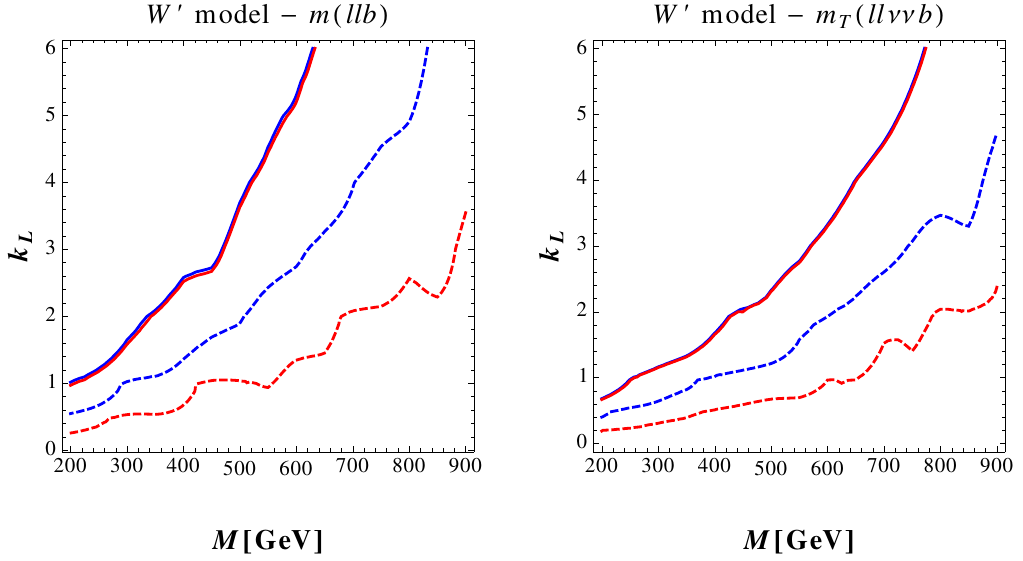
Figure 10 . 95% CL expected exclusion regions in the M vs k L plane: the left plot makes use of the m ( llb ) distribution while the right plot makes use of the m T ( ll(cid:23)(cid:23)b ) distribution. The solid (dashed) blue curves correspond to the pessimistic (optimistic) scenario at 300 fb (cid:0) 1 while the solid (dashed) red curves correspond to the pessimistic (optimistic) scenario at 3000 fb (cid:0) 1